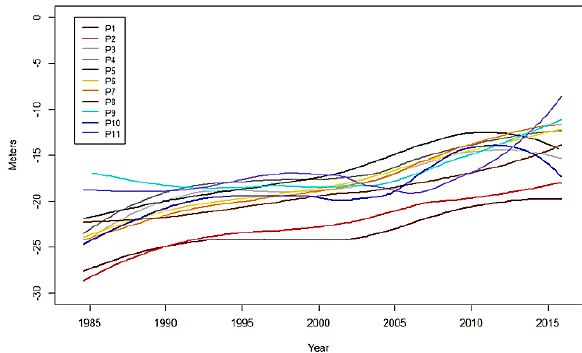
Figure 5. Temporal change of the estimated Secchi disk depth (m) at the eleven sample